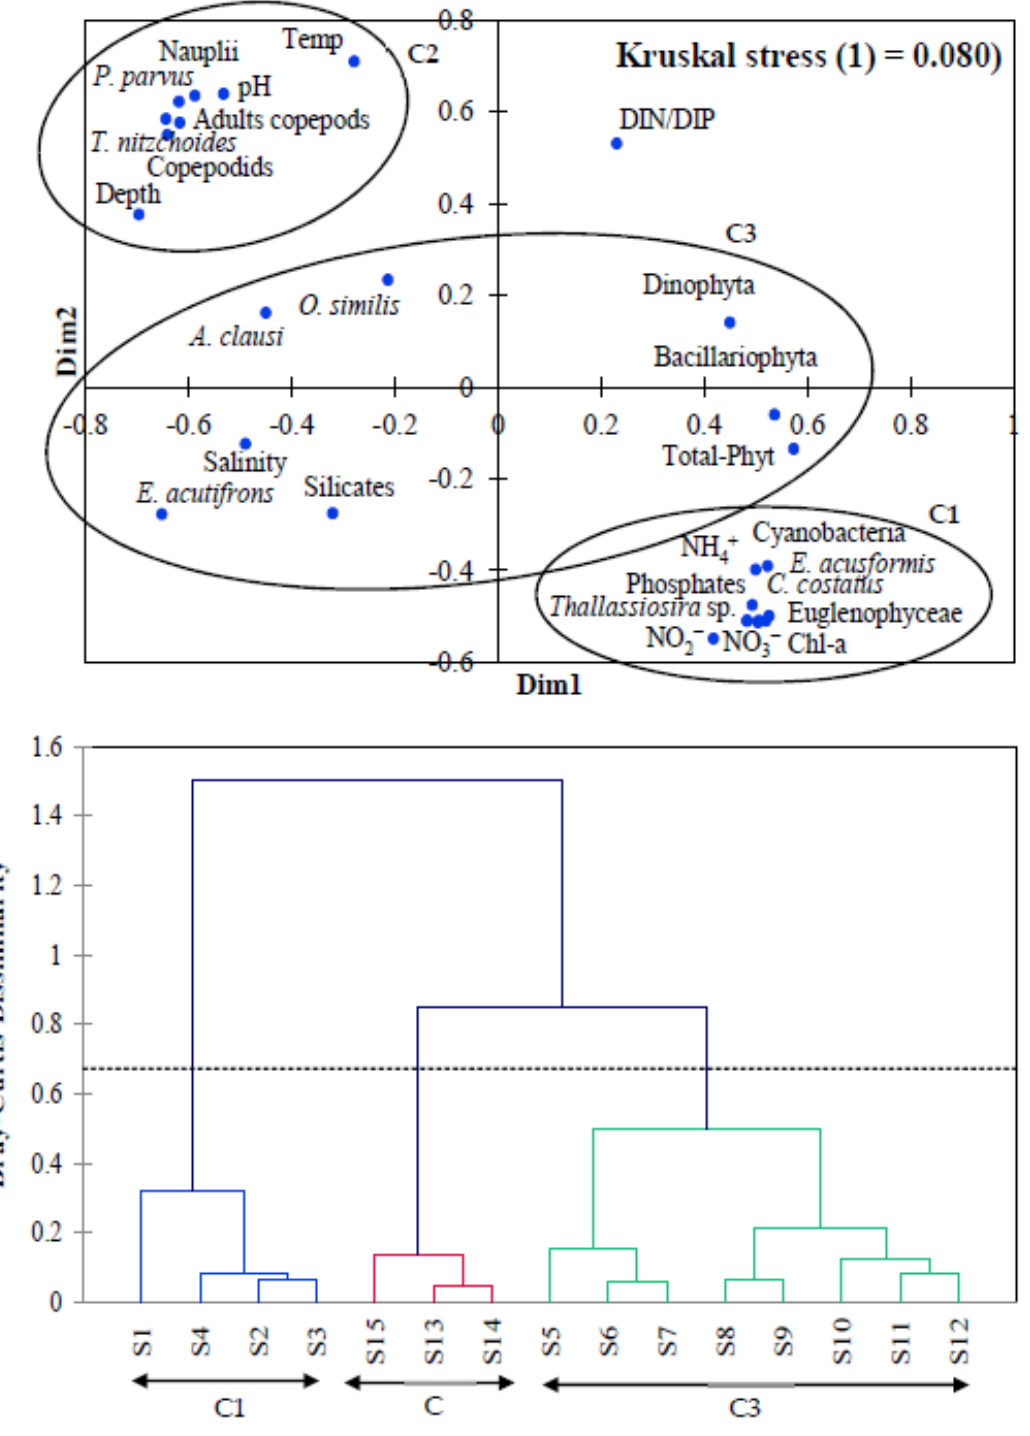
Figure 11. Two-dimensional MDS ordination of the groups and dominant taxa of phytoplankton (Phyt), copepods, and the physico-chemical variables. Dissimilarity among the stations was determined using the Bray – Curtis similarity index and was then superimposed on the MDS plot. The groups of stations (C1, C2, and C3) are highlighted on the dendrogram.